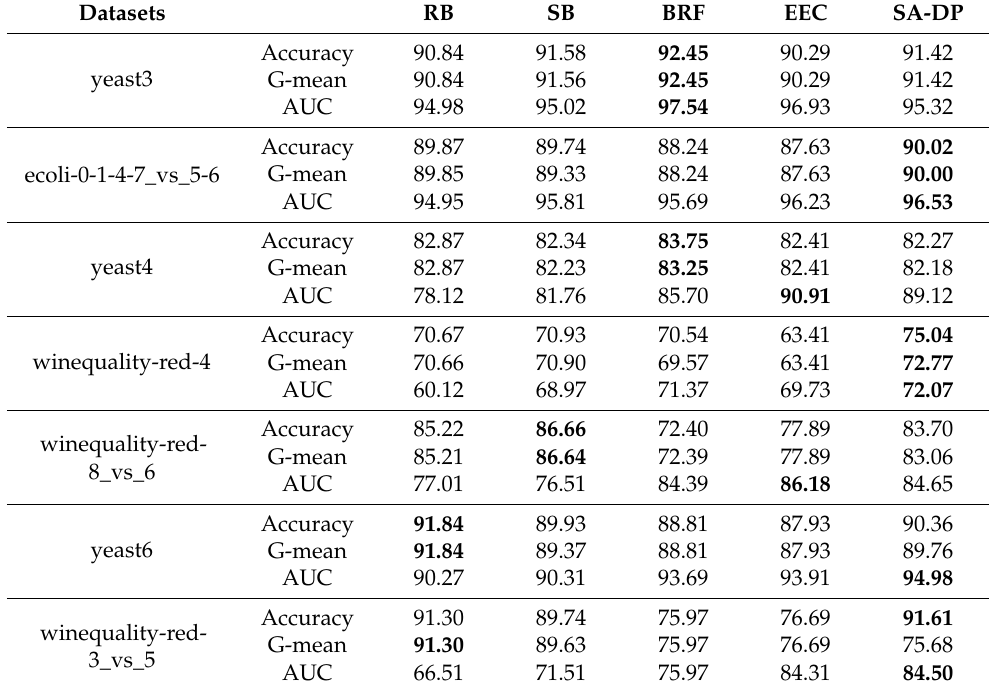
Table 9. Evaluation of model performance on other data sets (%), the bold represent the optimal result.